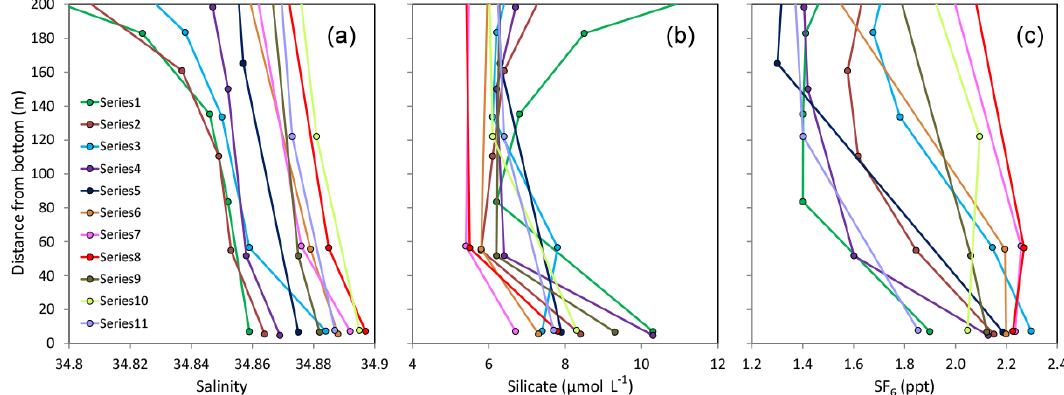
Figure 13. Salinity (a) , silicate (b) , and SF 6 (c) as a function of distance from the bottom for all stations deeper than 400m in sections D and F. Series 1 to 11 represent the bottom depth, increasing from 483 to 1120m.